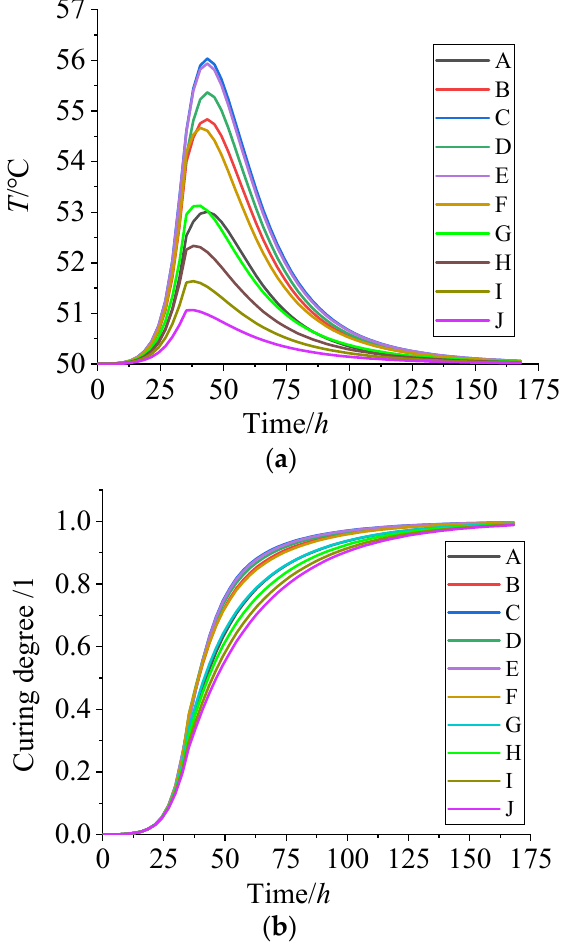
Figure 8. ( a ) Temperature vs. curing time. ( b ) Curing degree vs. curing time. It can be seen from Figure 8a that the temperature of the NEPE propellant grain first increases and later decreases on the whole. The arrival time of the highest temperature increased from 38 h to about 43 h with the node position moved from the periphery to the center of propellant grain. The maximum temperature of grain interior (the nodes of C, E) is 56 ◦ C at the curing time of 43 h. The periphery of the propellant grain, such as the nodes of J, is basically maintained at the curing temperature of 50 ◦ C. After curing for 150 h, the internal temperature of the propellant tends to be uniform, at about 50 ◦